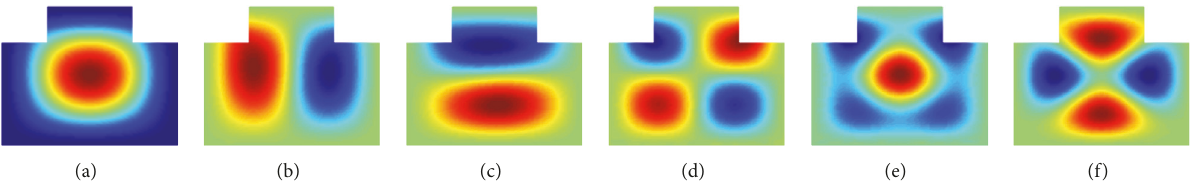
Figure 9: The first six mode shapes of the square plate with double edge cutouts. (a) The first mode; (b) the second mode; (c) the third mode; (d) the fourth mode; (e) the fifth mode; (f) the sixth mode. Table 6: The first six natural frequencies (Hz) for different cutout